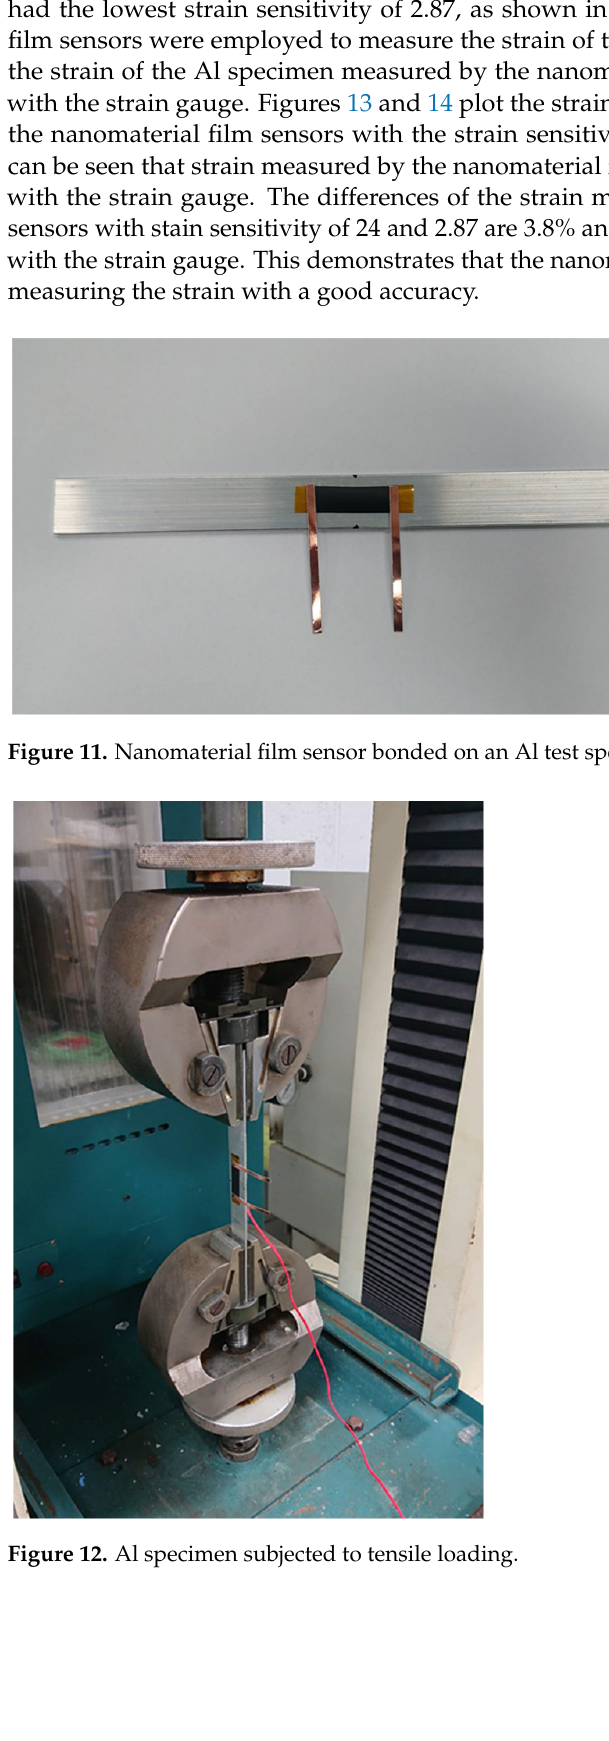
Figure 12. Al specimen subjected to tensile loading.